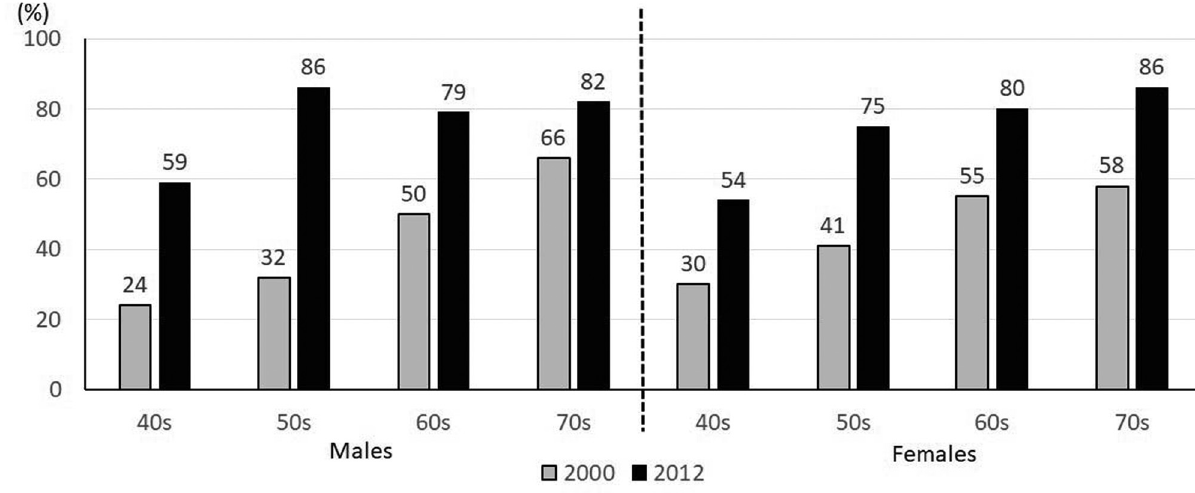
Figure 3: The ratio of sexless people across age groups in percentage ( Araki [ 28 ])